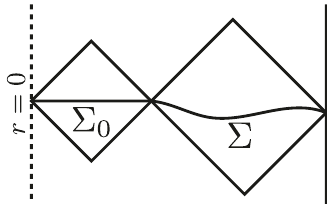
Figure 7 . Construction of the simplified spacetime. The slice Σ 0 has intrinsic and extrinsic geometry of a static slice of AdS.